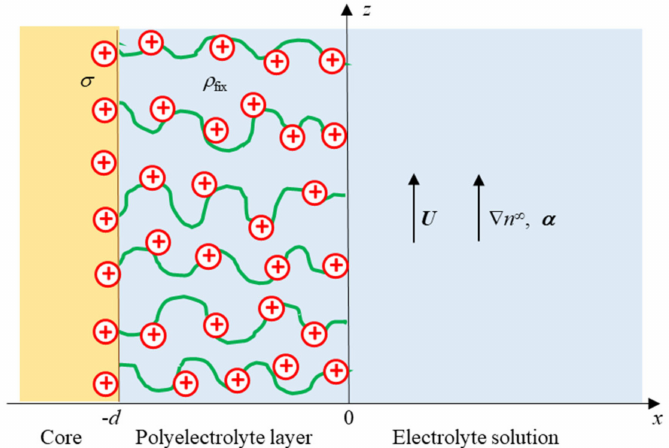
Figure 1. Soft particle consisting of the core covered with an ion-penetrable surface layer of poly- electrolytes of thickness d . The particle moves with diffusiophoretic velocity U in an electrolyte concentration gradient ∇ n ∞ or with the corresponding vector a . U is parallel to ∇ n ∞ and α . ρ fix is the fixed charge density in the polyelectrolyte layer, and s is the surface charge density of the particle